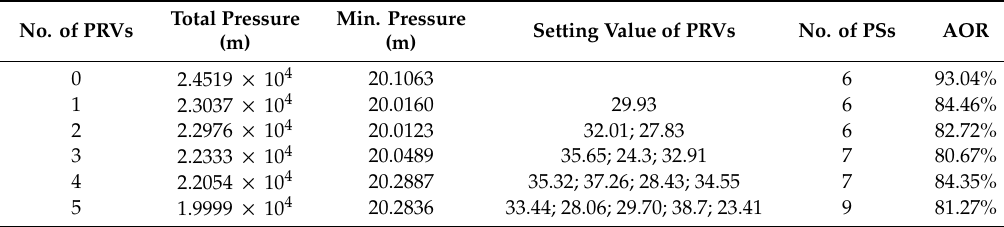
Table 1. Total pressure (24 h) with PRVs and AOR with PSs.